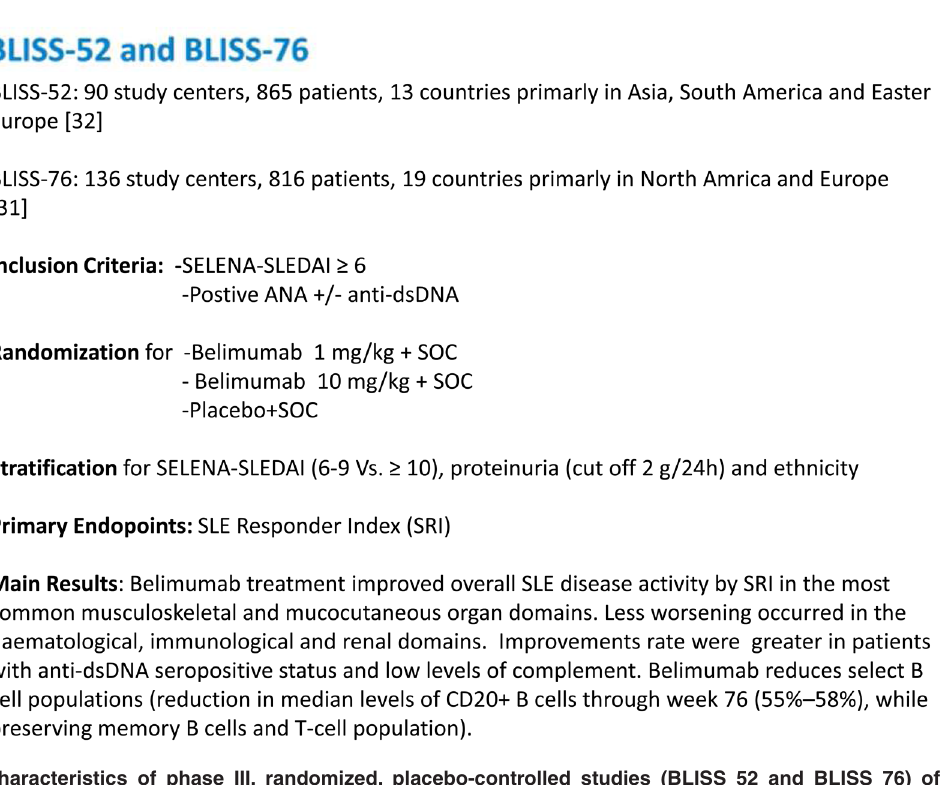
Figure 2. Main characteristics of phase III, randomized, placebo-controlled studies (BLISS 52 and BLISS 76) of belimumab, a monoclonal antibody that inhibits B-lymphocyte stimulator, in patients with systemic lupus